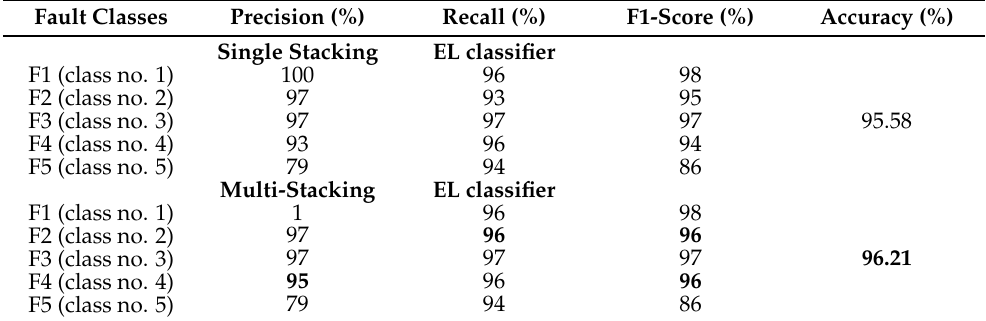
Table 4. The calculated error metrics of the fault classification method (single and multi-stacking EL). Fault Classes